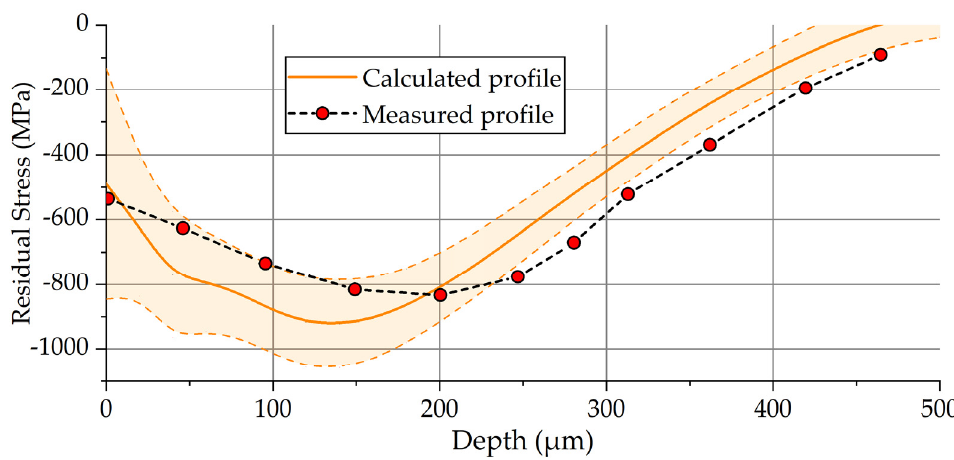
Figure 12. Comparison between industrial shot mix and experimentally measured residual stress profiles.